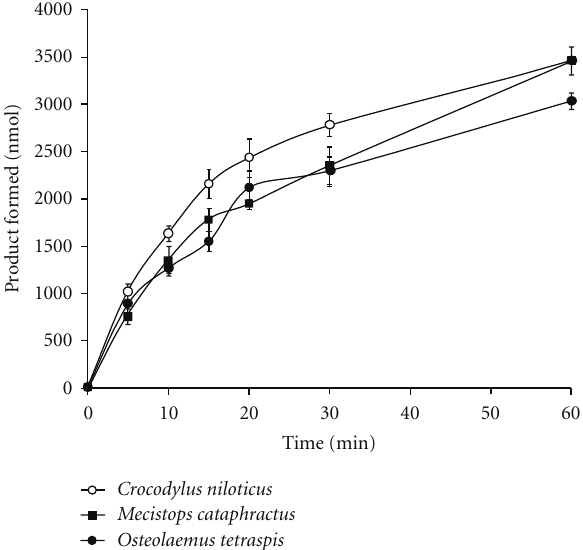
Figure 3: The results represent the means ± standard deviations of four independent